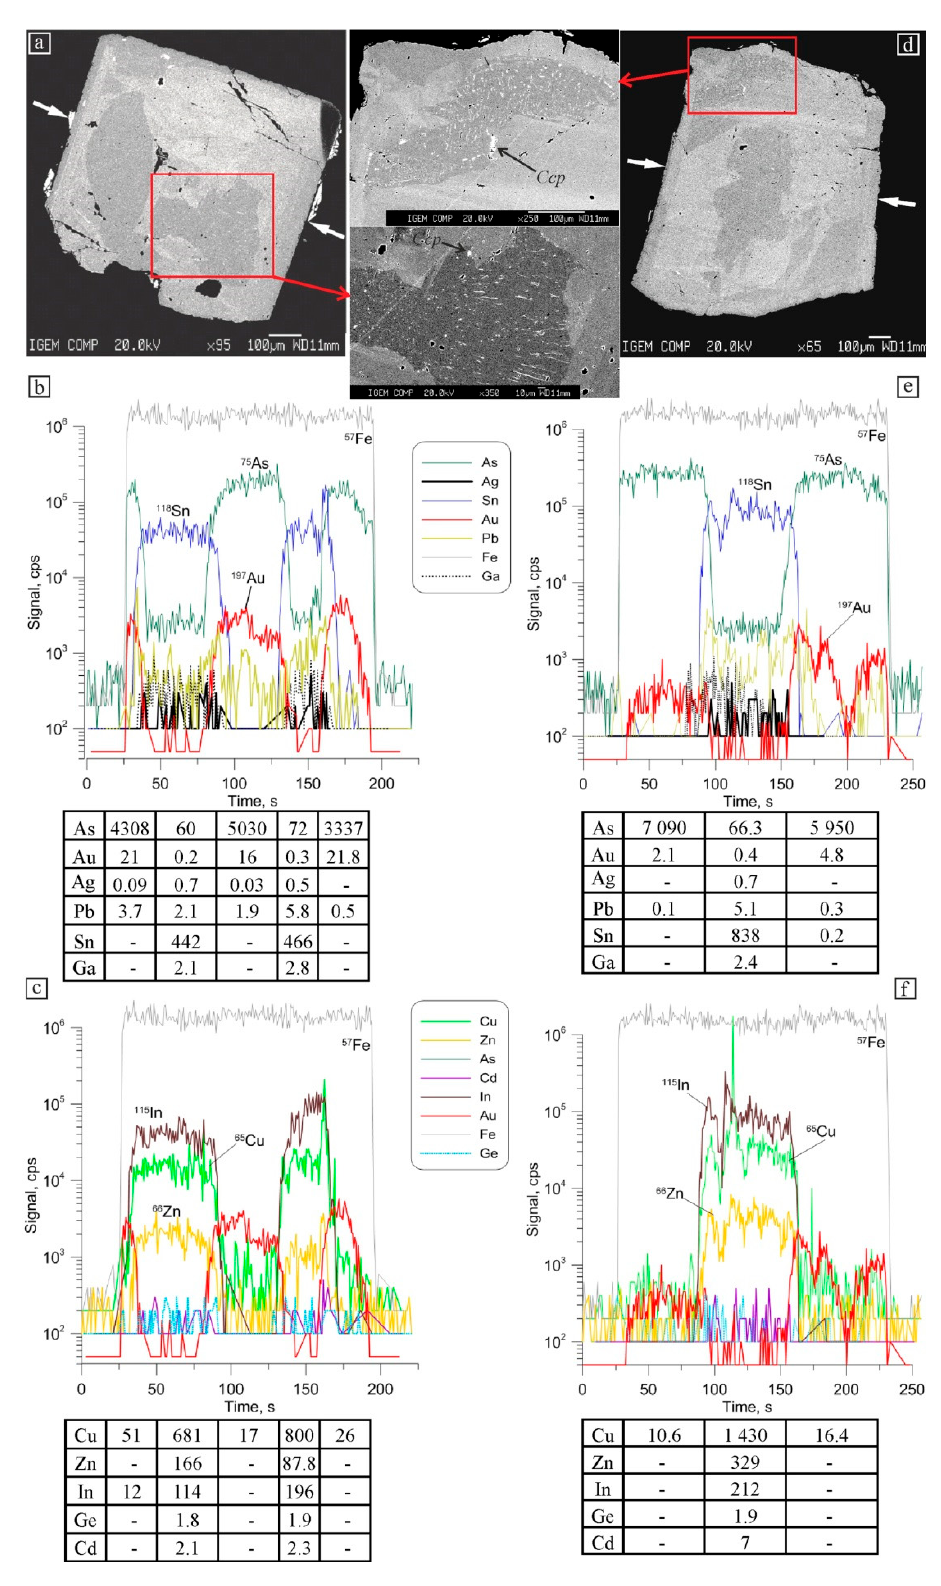
Figure 11. Graphic images of the two probing profiles for the pyrite crystals from the sulphide-quarts veins of the Pervopavlovsk dyke, the Berezovsk deposit. BSE images ( a , c ), cursors indicate the location of the probing profiles, LA-ICPMS profile length ( b , d – f ): left—842 µ m, right—330 µ m. Frames in ( a , c ) indicate the areas with stannite (small, elongated) and chalcopyrite (Ccp) inclusions, see the insets.